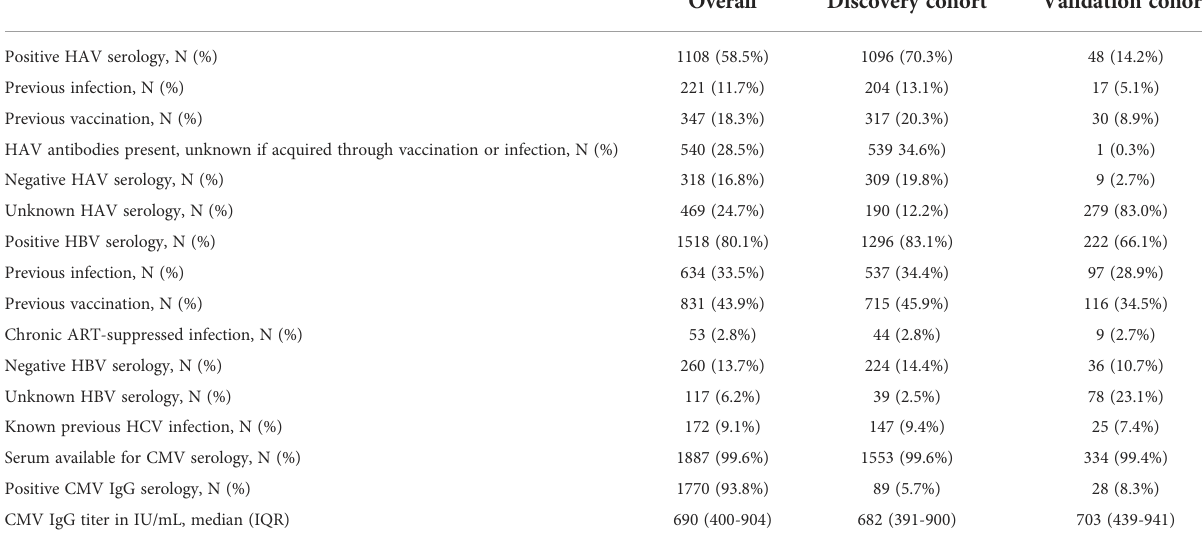
TABLE 3 Baseline viral co-infections of study